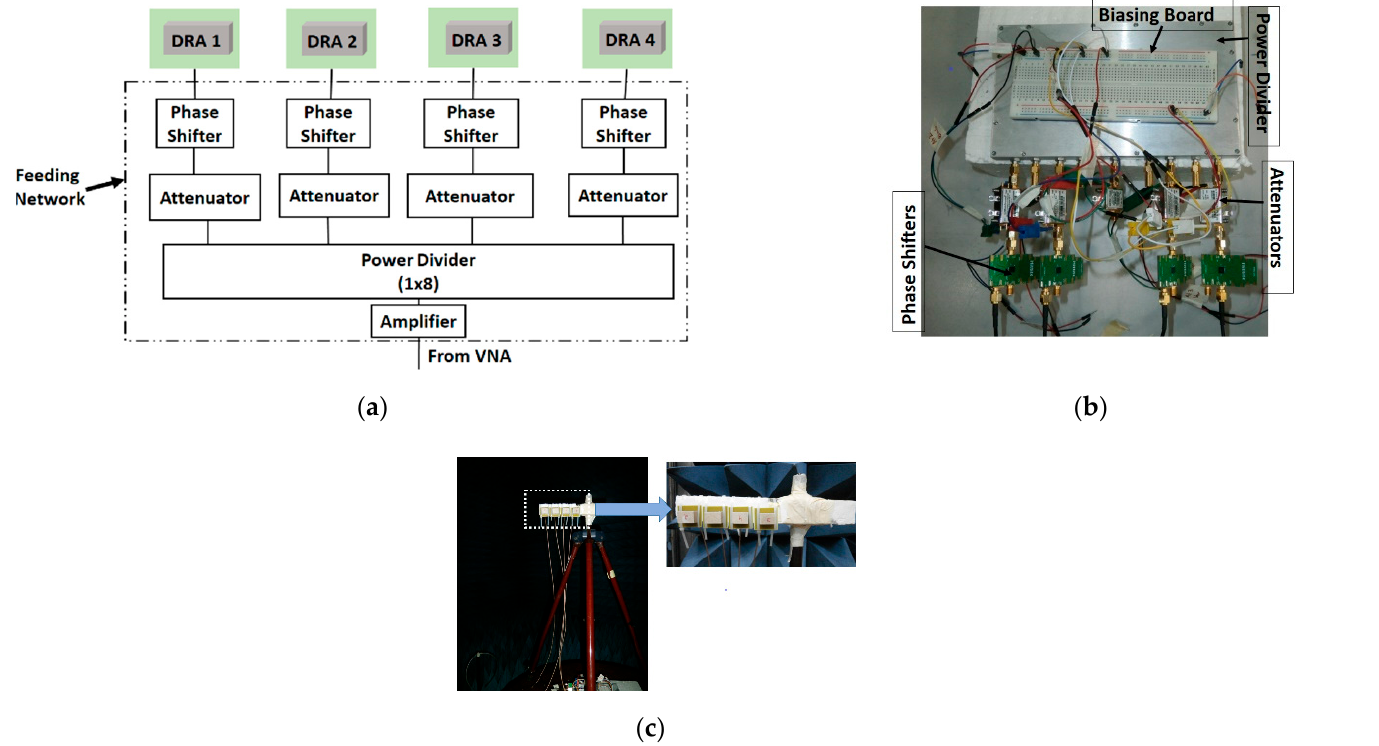
Figure 2. Measurement setup: ( a ) block diagram; ( b ) feed network; and ( c ) anechoic chamber setup. The array factor (AF) for the array shown in Figure 1 can be written as